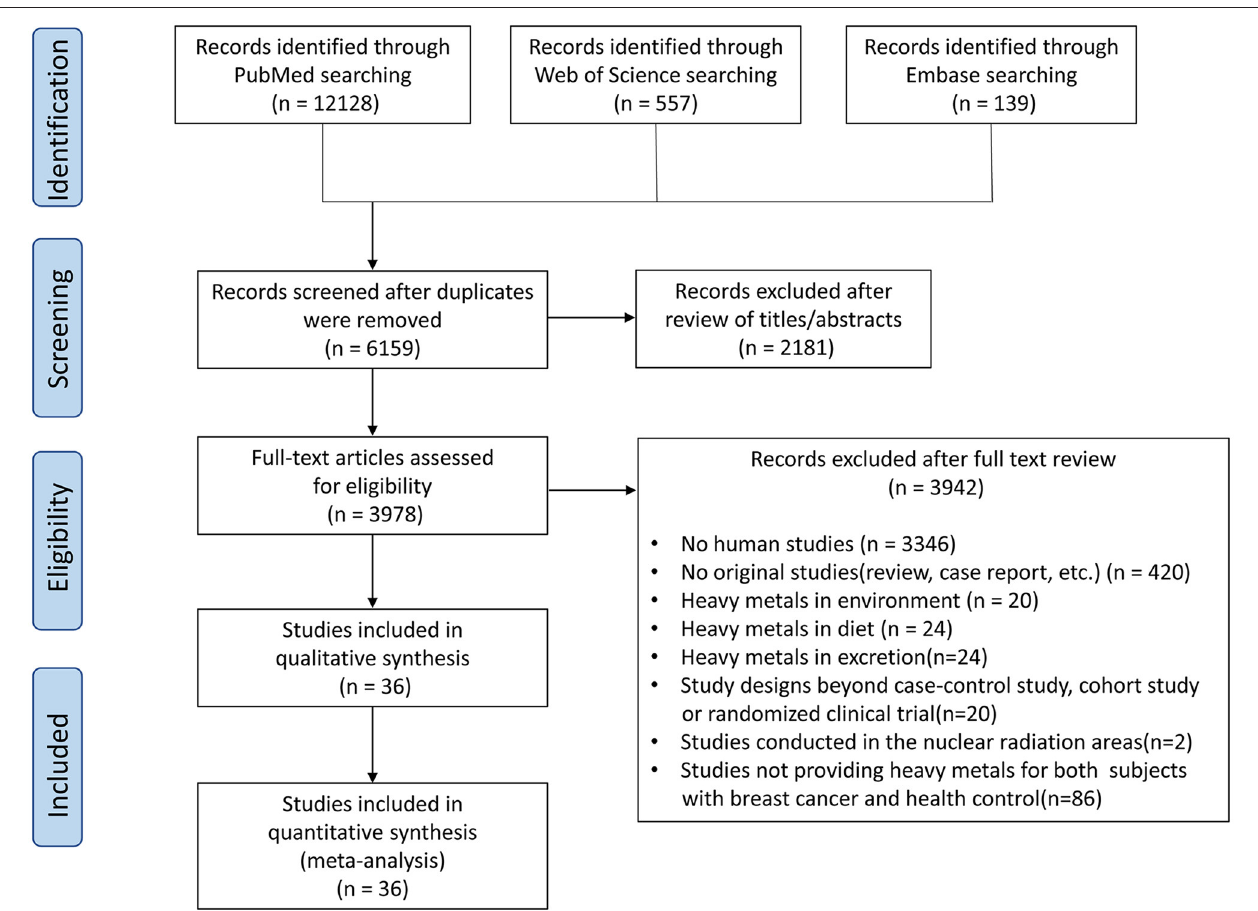
FIGURE 1 | Working flowchart for the systematic selection of studies for this meta-analysis.